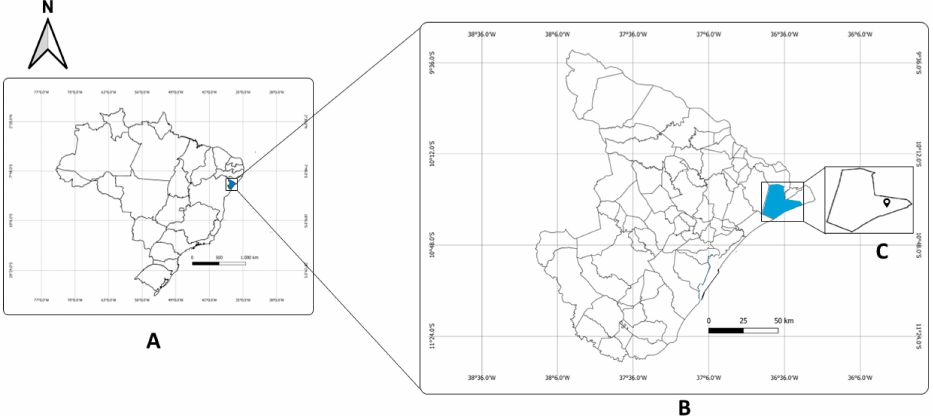
Figure 1. ( A ) Map of Brazil; ( B ) Map of the State of Sergipe (Brazil) showing Pacatuba municipality ( C